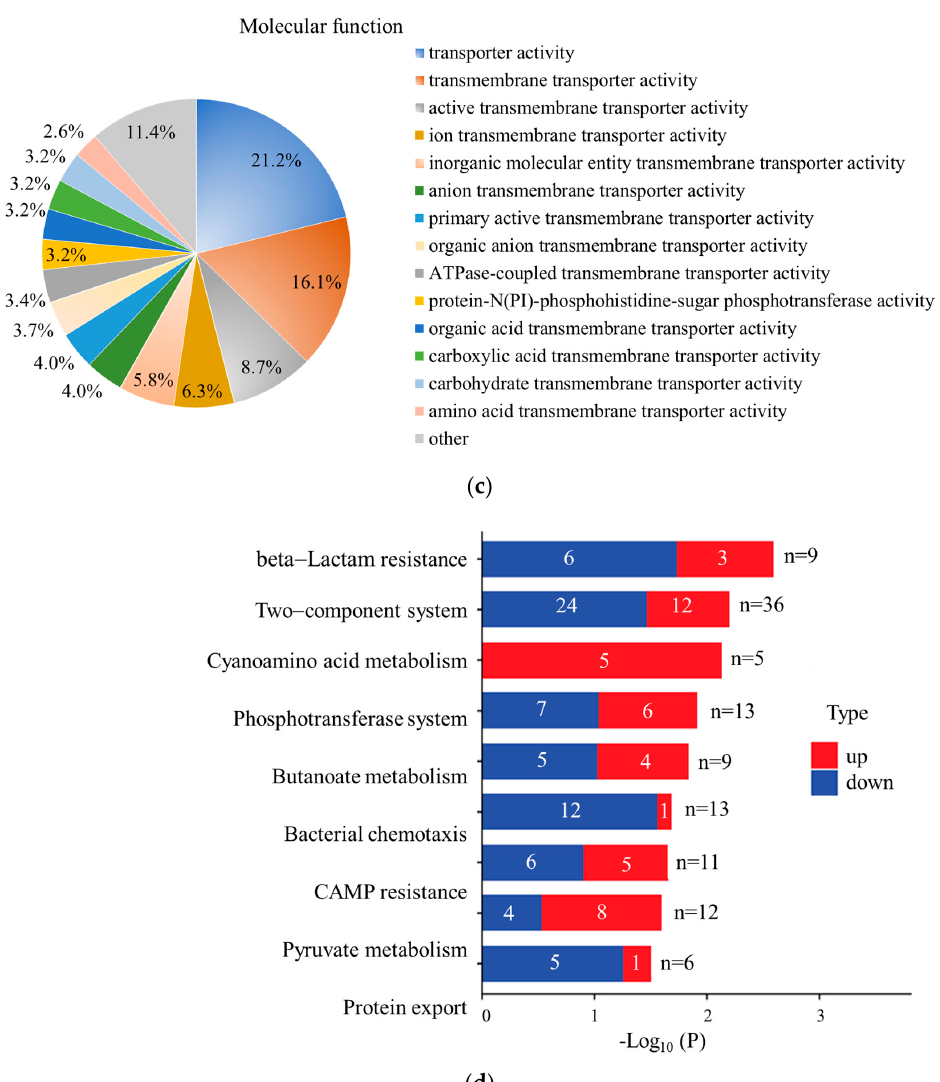
Figure 7. GO annotation of differentially expressed proteins after treatment with RTMBE, including a biological process ( a ), cellular component ( b ) and molecular function ( c ). KEGG pathway enrichment analysis ( d ). Experiments were performed in triplicate, and data are shown as the mean ± SD.